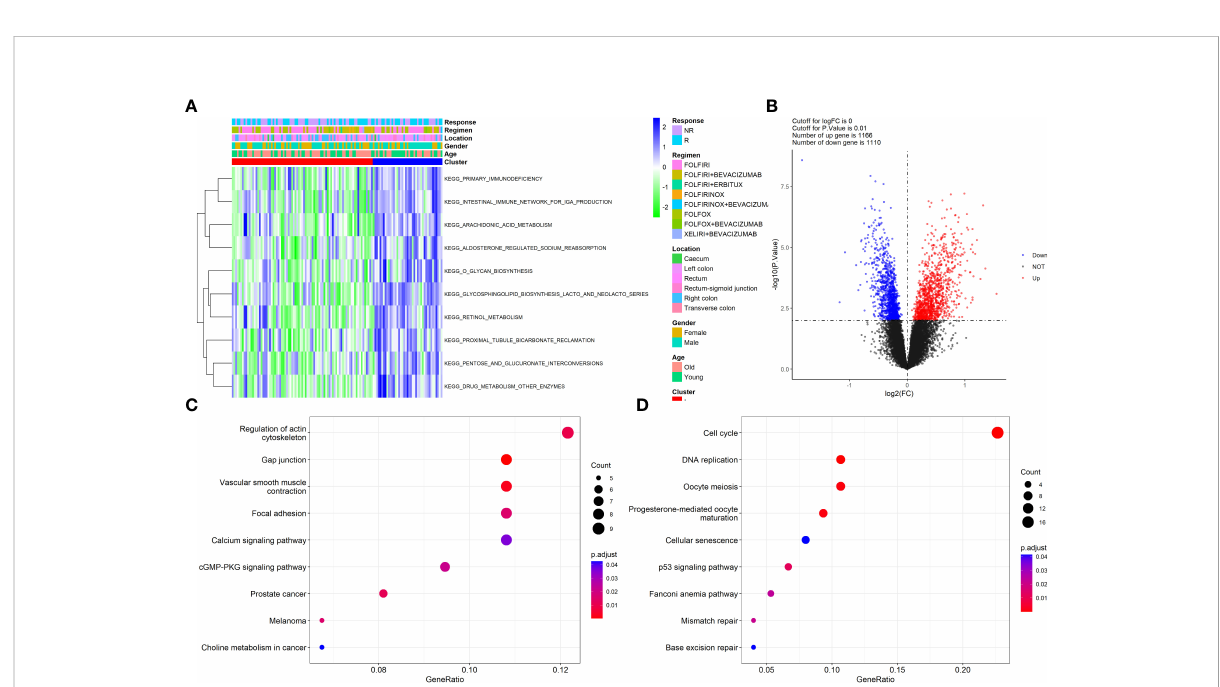
FIGURE 2 Functional enrichment of clusters and the DEGs. (A) Heatmap of GSVA analysis revealed the signi fi cant pathways that Clusters involved; (B) Volcano plot showed the DEGs between the two clusters; (C) KEGG pathways that up-regulated DEGs involved; (D) KEGG pathways that down- regulated DEGs